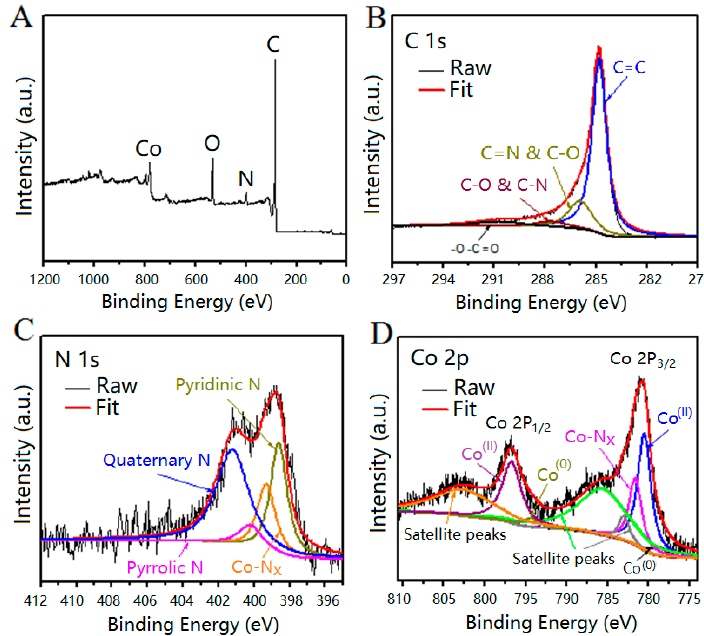
Figure 5. X-ray photoelectron spectrometer (XPS) spectrum of Co@N-C-800. ( A ) Survey spectra; the high resolution spectrum of ( B ) C 1s, ( C ) N 1s, and ( D ) Co 2p.